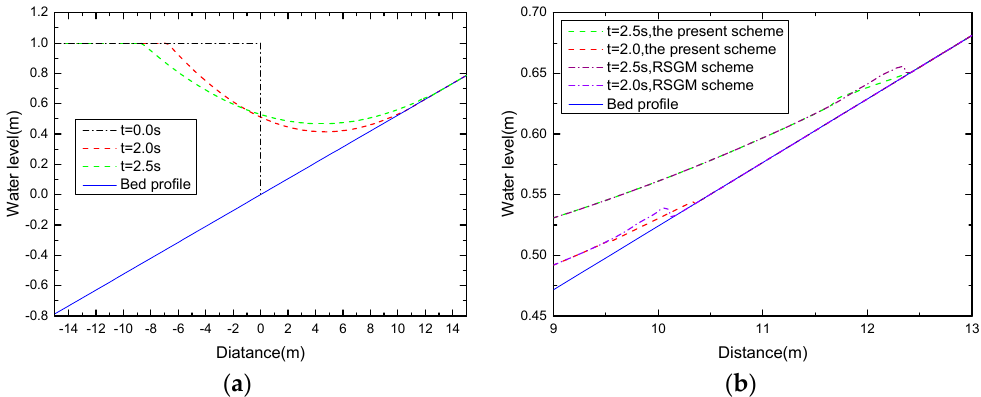
Figure 13. Dam-break problem over a plane for α = π /60: ( a ) the water level at t = 0.0 s, 2.0 s and 2.5 s; ( b ) comparison of the revised surface gradient method (RSGM) scheme and the present scheme at t = 2.0 s and 2.5 s near the wet/dry front.